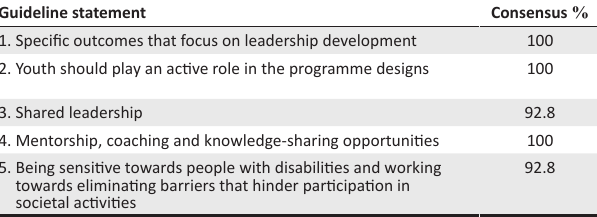
TABLE 2: Guidelines for leadership development through leisure, recreation, sports, physical activities and activities of daily living.